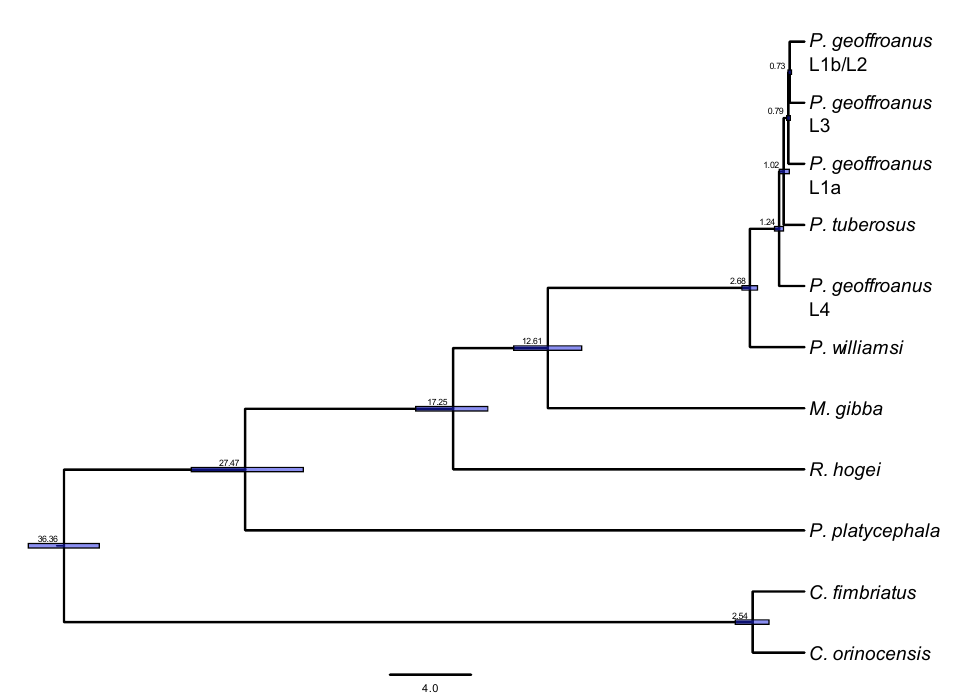
Figure 4. Dated species tree of Chelidae with emphasis on the Phrynops geoffroanus species complex assuming the second most likely taxonomic hypothesis ( P. tuberosus , P. geoffroanus L4 coastal Atlantic drainages, P. geoffroanus L1a Paraná basin, P. geoffroanus L3 São Francisco basin, P. geoffroanus L1a + L2 Amazon basin) .